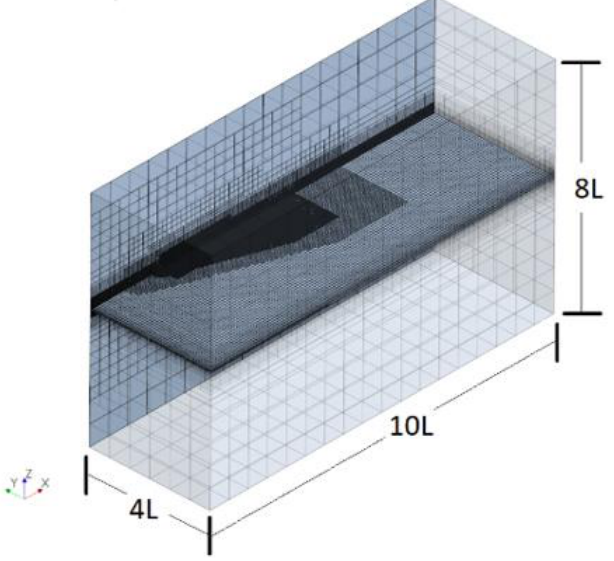
Figure 4. Mesh in the background region.